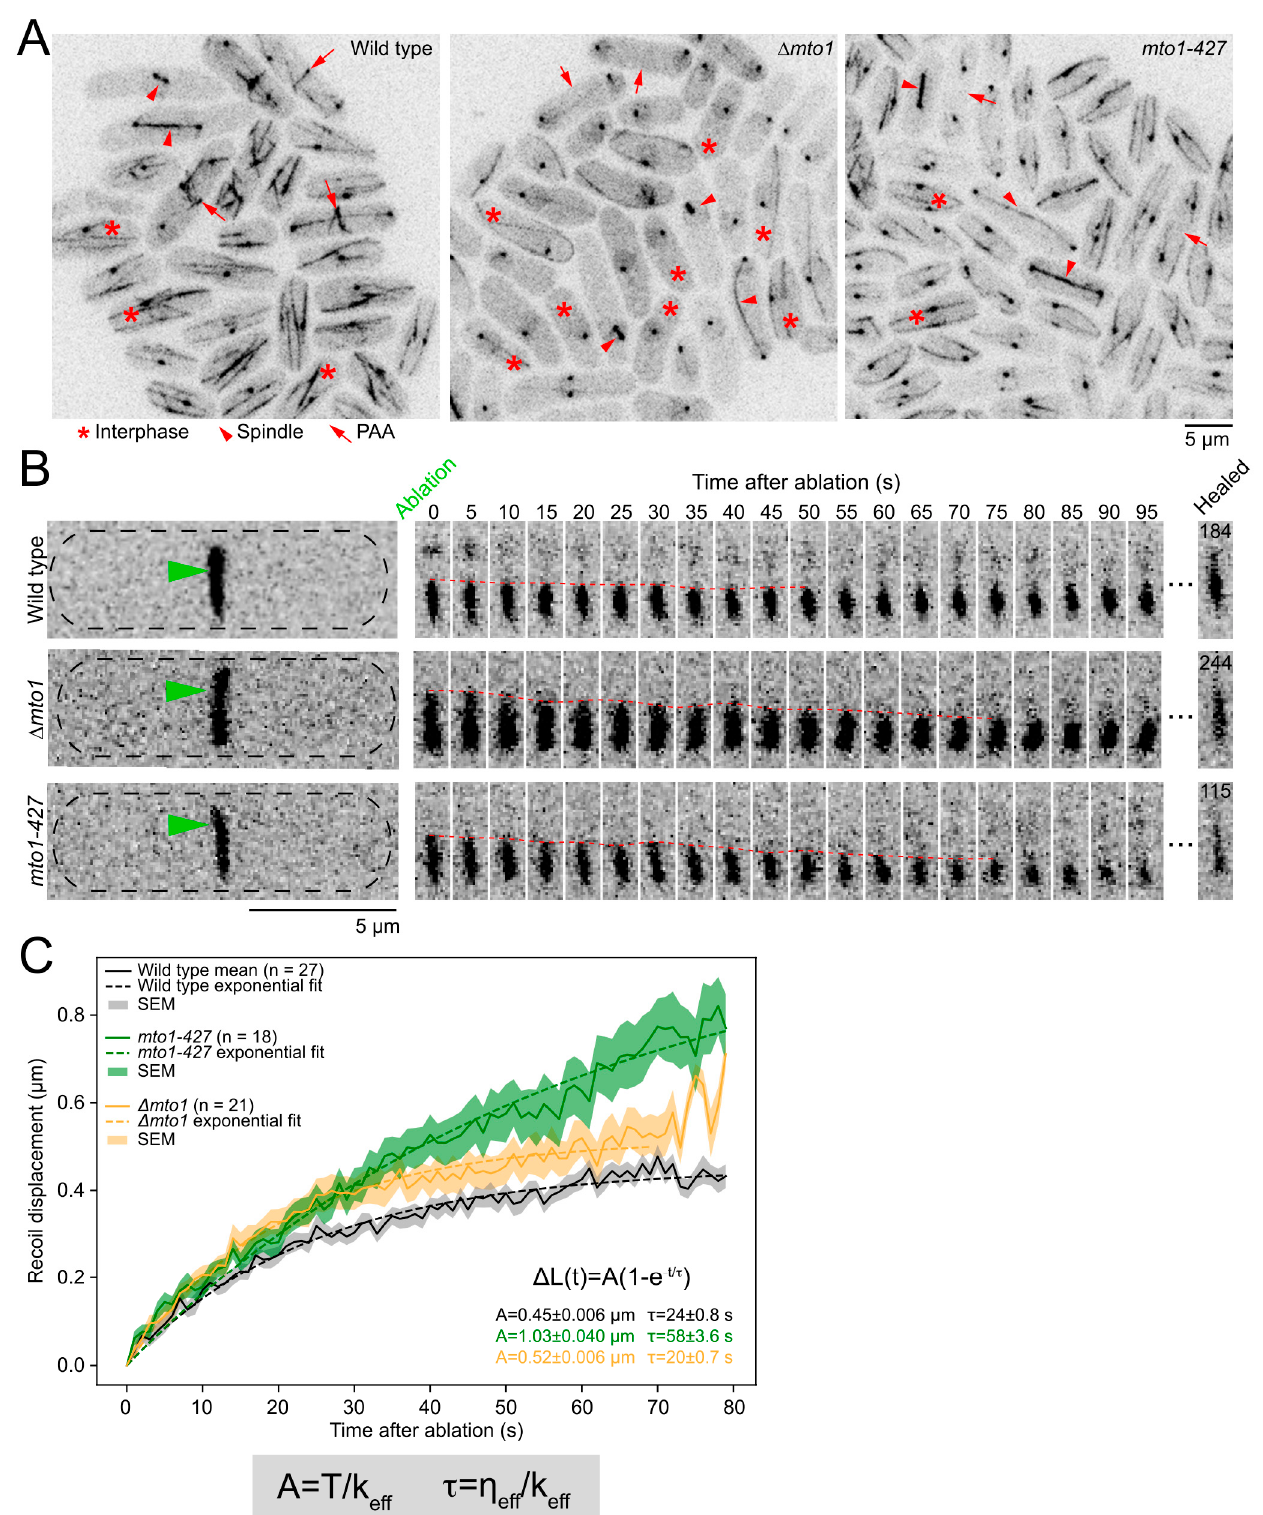
Figure 3. PAA microtubules impart stiffness to the contractile ring. ( A ), Confocal fluorescence micrographs of fields of cells labeled as GFP-Atb2p and Sad1p-mEGFP in wild-type, ∆ mto1 , and mto1- 427 cells. ( B ), Time-lapse montages of wild-type (top), ∆ mto1 (middle), and mto1-427 cells (bottom) before and after laser ablation. Green arrowheads, sites of ablation. Dashed red line, position of the severed tip over time. Time of healing after laser ablation is listed for each genotype inside the frame of the micrograph. ( C ), Graph of the recoil displacement of severed tips in wild-type, ∆ mto1 , and